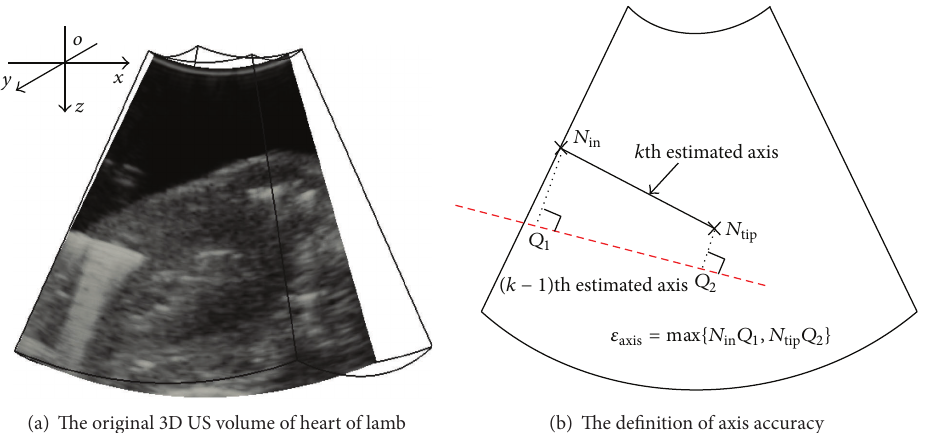
Figure 3: The diagram for the definition of axis accuracy.